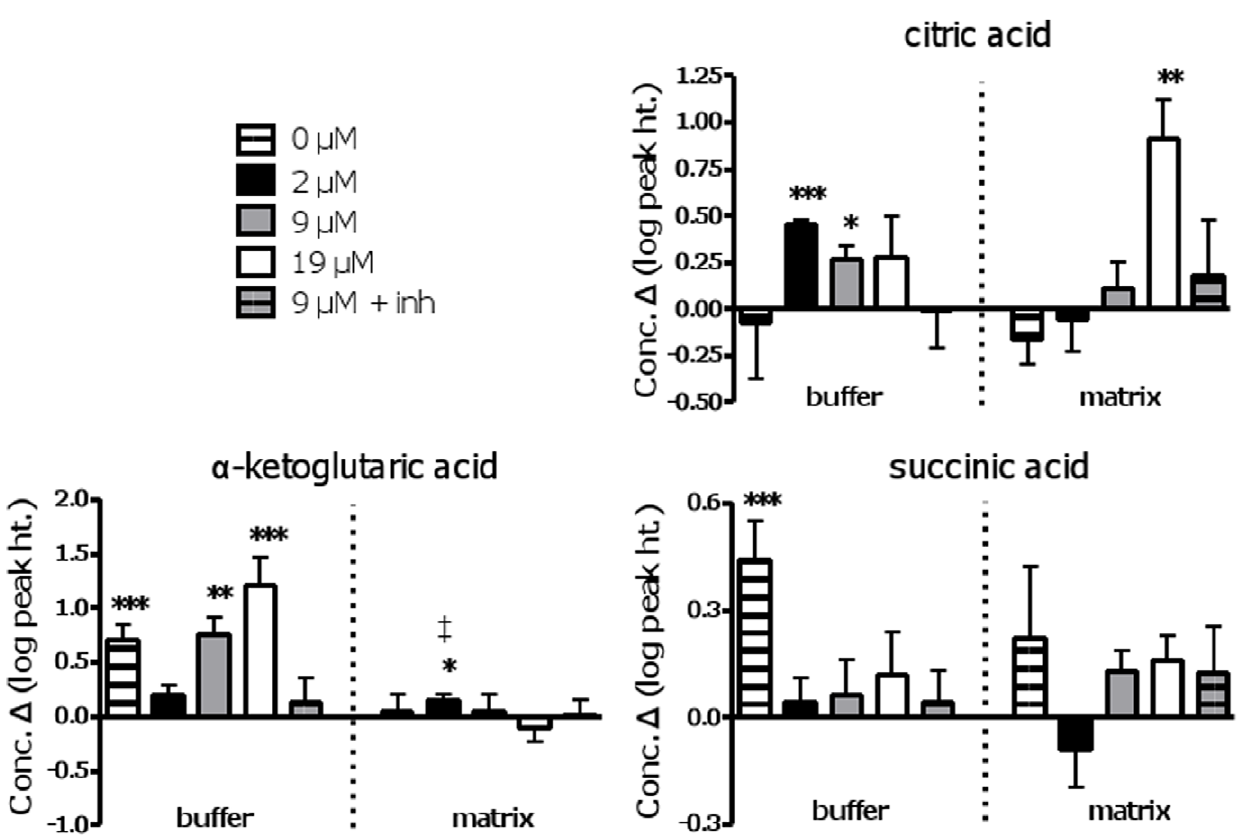
Figure 5. Changes in detected TCA cycle intermediates over time in buffer and matrix fractions obtained from muscle mitochondrial preparations. All 5 conditions are shown (0, 2, 9 and 19 m M palmitate, and 9 m M palmitate plus inhibitors) for both fractions (matrix and buffer). Values are the log of the change in concentration (peak height) over a 20-min incubation. Buffer and matrix fractions can be compared within each metabolite. Significance: paired t-test, 0 vs . 20 min, within treatment; * P , 0.05; **, P , 0.02, *** P , 0.005. { : indicates that an outlier was removed from either the 0 or 20 min group for that metabolite in that fraction.